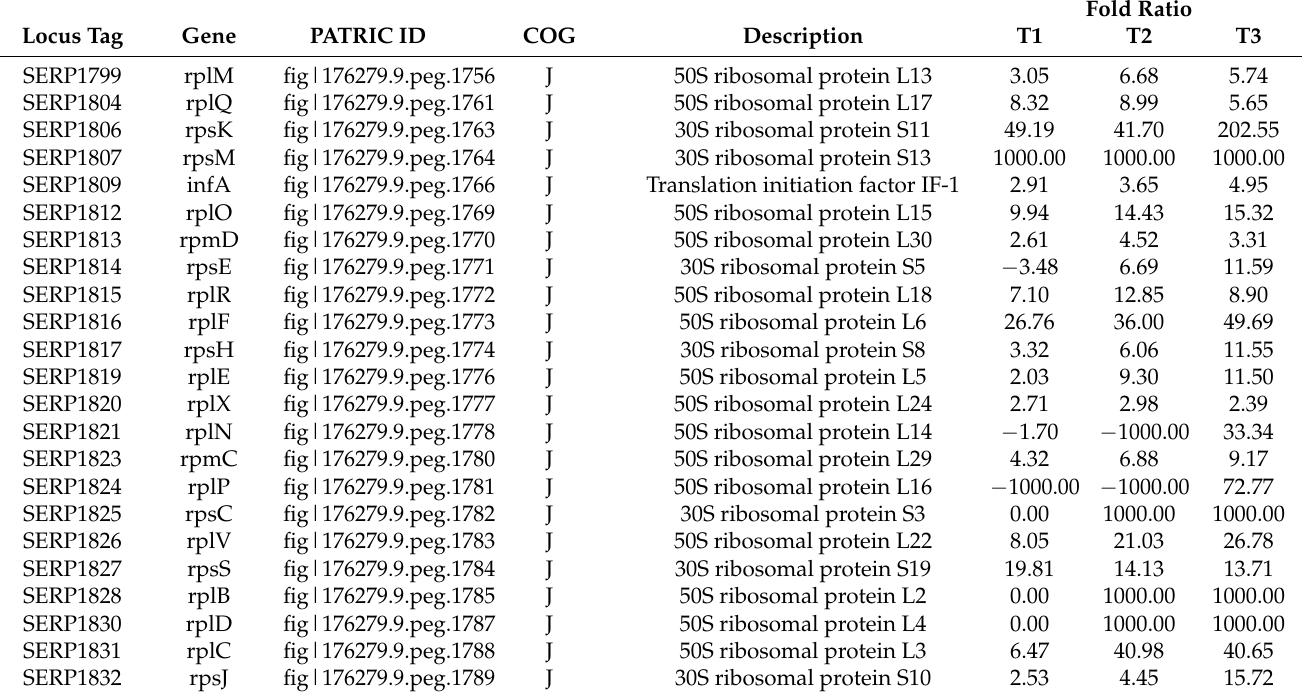
fig|176279.9.peg.1789